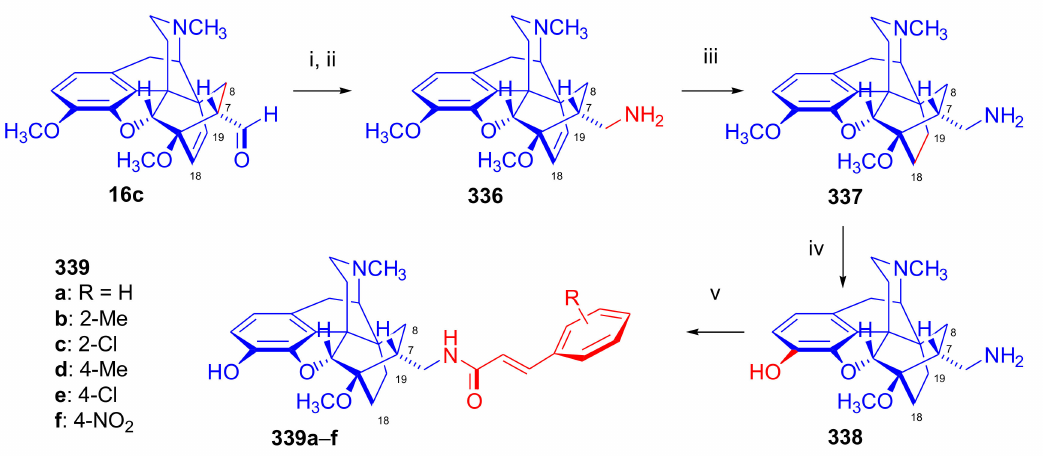
Figure 86. Synthesis of aryl substituted cinnamoyl derivatives of 7 α -aminomethyl- N 17 -methyl-6,14- endo -ethanotetrahydoro-nororipavine. Reagents and conditions : (i): NH 2 OH · HCl, EtOH-H 2 O 1:1 ( v/v ), reflux, 6 h; (ii): LiAlH 4 , THF, reflux; (iii): H 2 , Pd-C, EtOH, 40 bar; (iv): BBr 3 , CH 2 Cl 2 , under